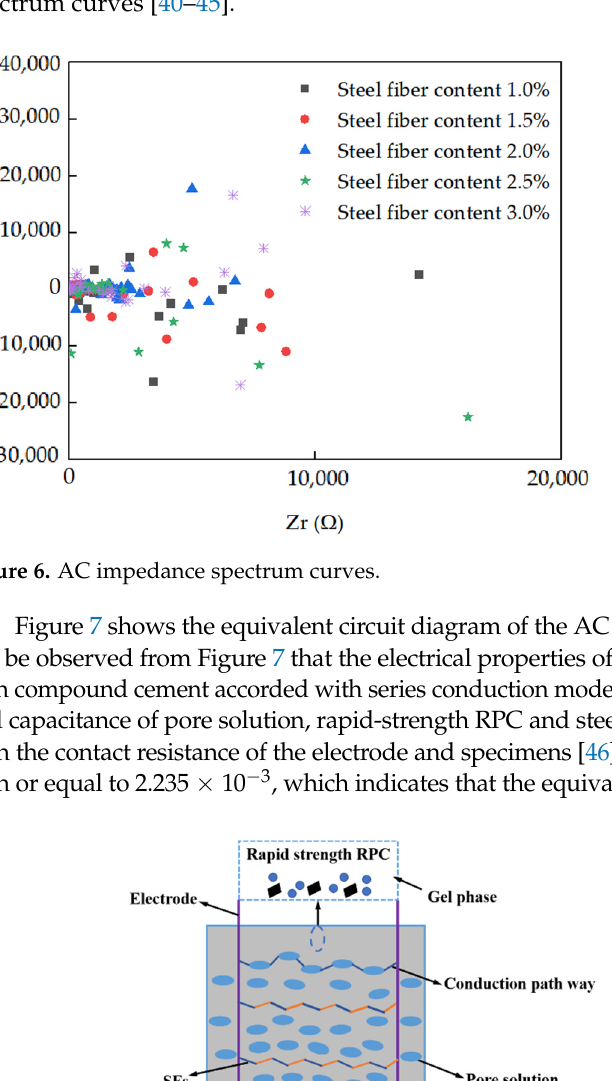
Figure 5. Electrical resistance of steel-fibers-reinforced reactive powder concrete.